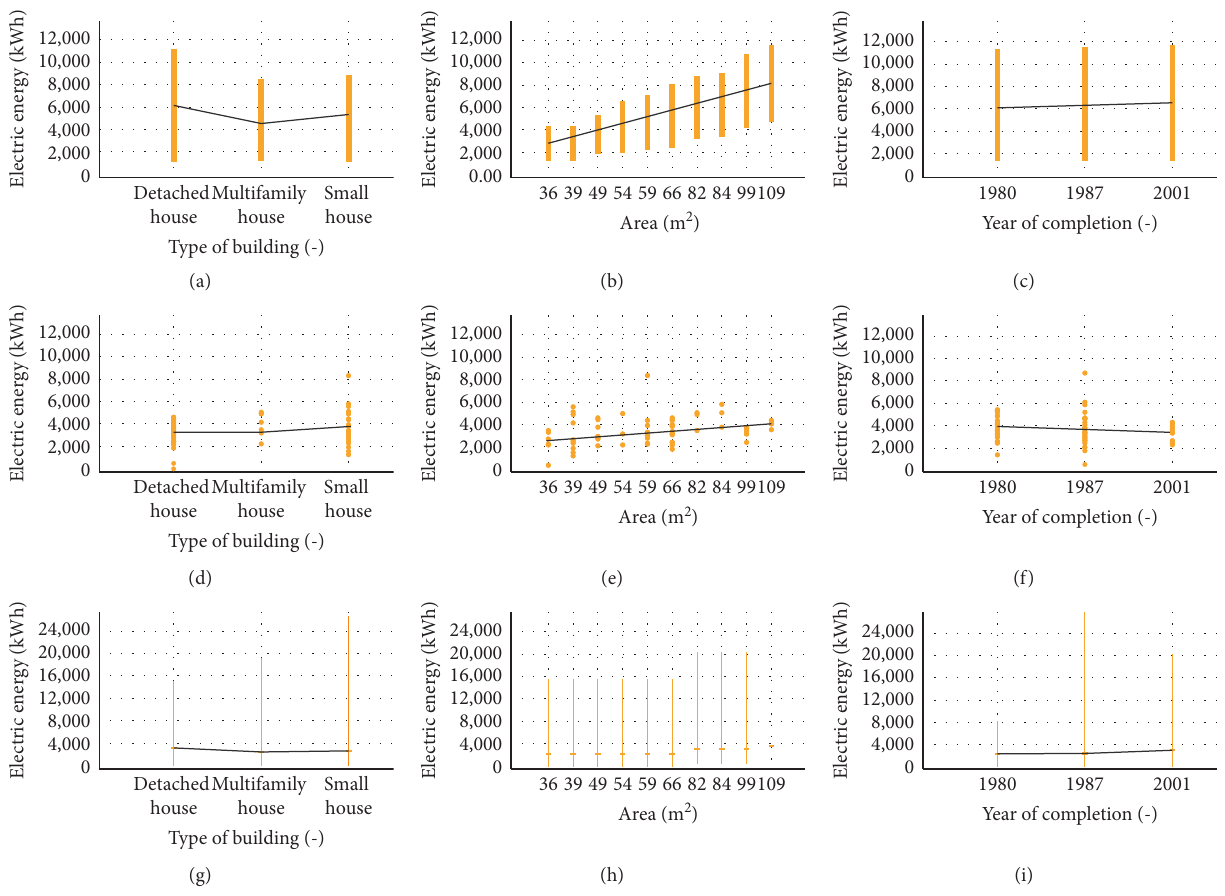
Figure 10: Analysis of electrical energy usage patterns based on data. (a) Standard model: type of building. (b) Standard model: area. (c) Standard model: year of completion. (d) Collected data: type of building. (e) Collected data: area. (f) Collected data: year of completion. (g) National Statistics: type of building. (h) National Statistics: area. (i) National Statistics: year of